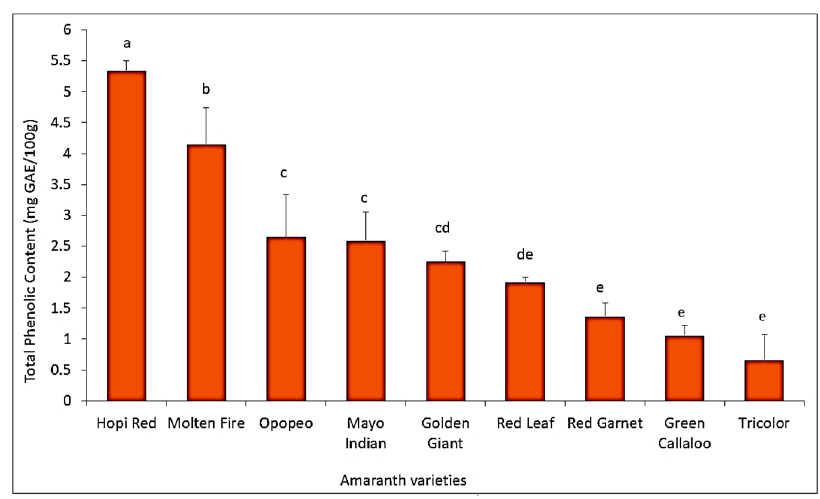
Figure 9. Total leaf polyphenol content (average ± SE) among amaranth varieties. Bars with the same letters are not significantly different using Fisher’s LSD ( p < 0.05).